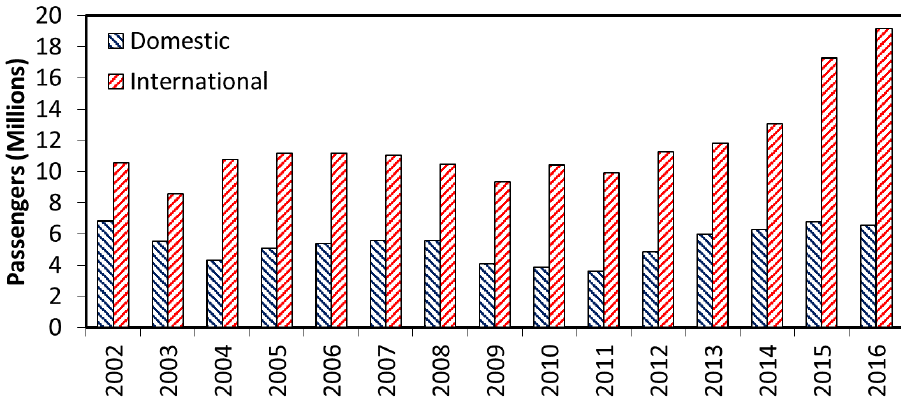
Figure 1. The annual domestic and international passenger traffic at KIX: 2002 to 2015. Source: data derived from Reference [61].